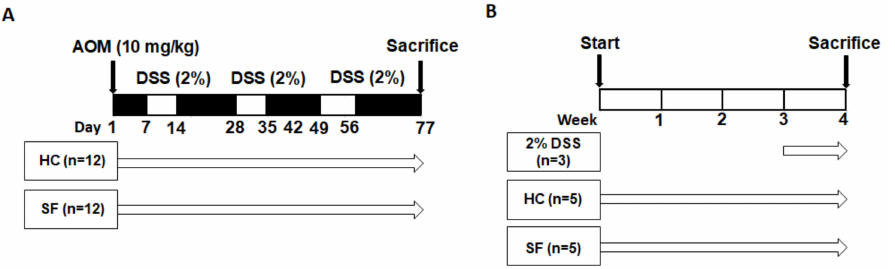
Figure 5. Schematic representation of the experimental protocols. ( A ). Schematic design of Experi- ment 1. A single intraperitoneal injection of 10 mg/kg azoxymethane (AOM) was given to mice